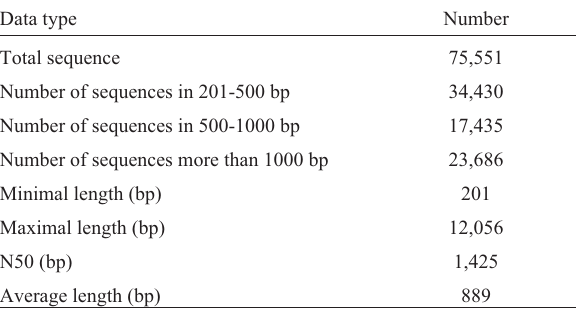
Table 1 - Summary of de novo assembled alfalfa